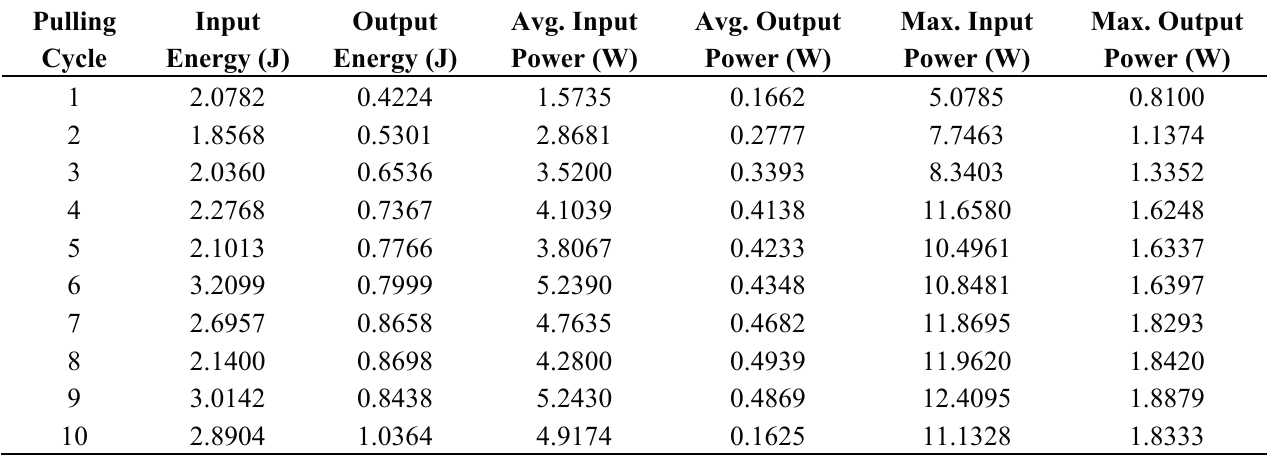
Table 4. Comparison of the mechanical pulling input and electrical voltage output in all